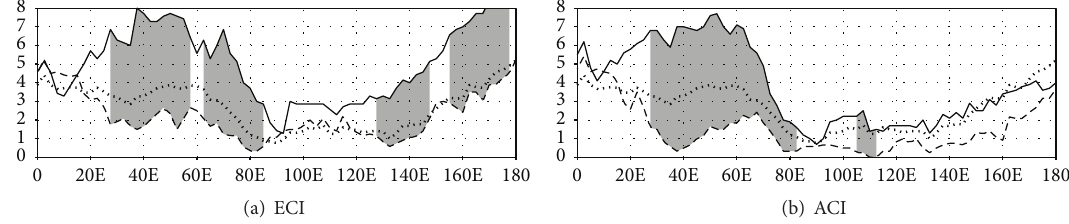
Figure 9: Composites of winter blocking frequency associated with high-low ECI years ((a) unit: days) and high-low ACI years ((b) unit: days). The solid curve (long dashed curve) denotes composites for the high (low) index years, and the dotted curve denotes the climatological values during 1979–2013. The shaded area indicates longitudes where the difference between composites exceeds the 0.1 significance.